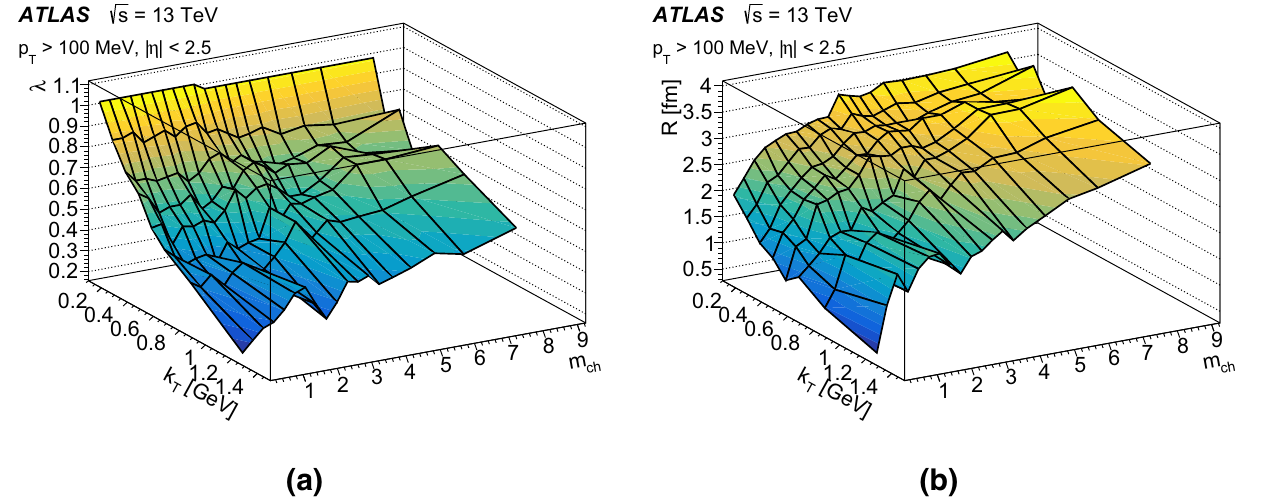
Fig. 7 The two-dimensional dependence on m ch and k T for p T > 100 MeV for a the correlation strength, λ , and b the source radius, R , obtained from the exponential fit to the R 2 ( Q ) correlation functions using the MB sample for m ch ≤ 3 . 08 and the HMT sample for m ch > 3 . 08